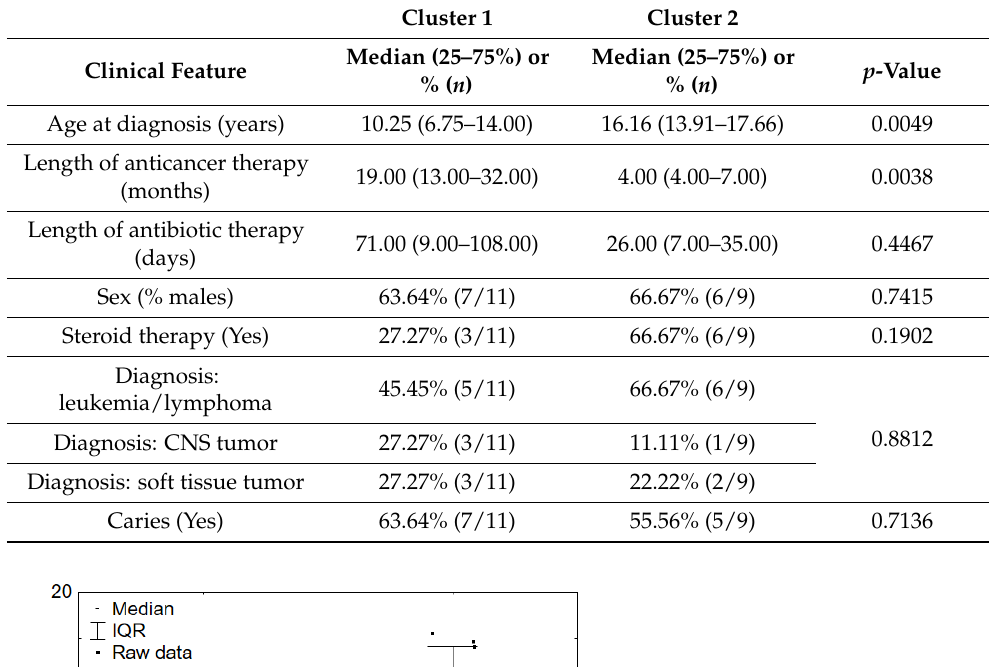
Table 4. Clinical characteristics of the patients according to the cluster adherence.